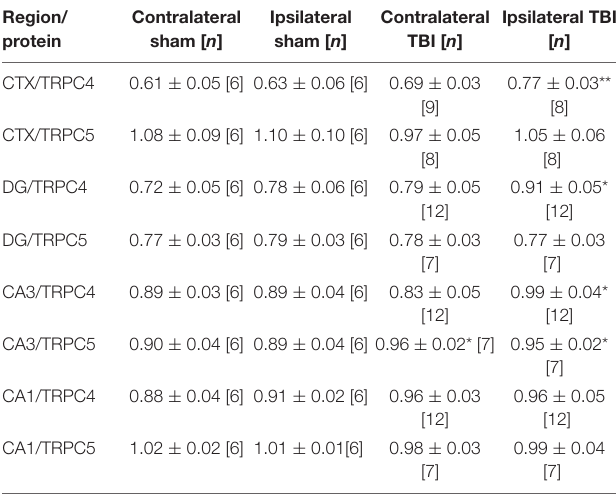
TABLE 2 | Normalized TRPC4/TRPC5 protein in 7-day sham and TBI mice. Region/